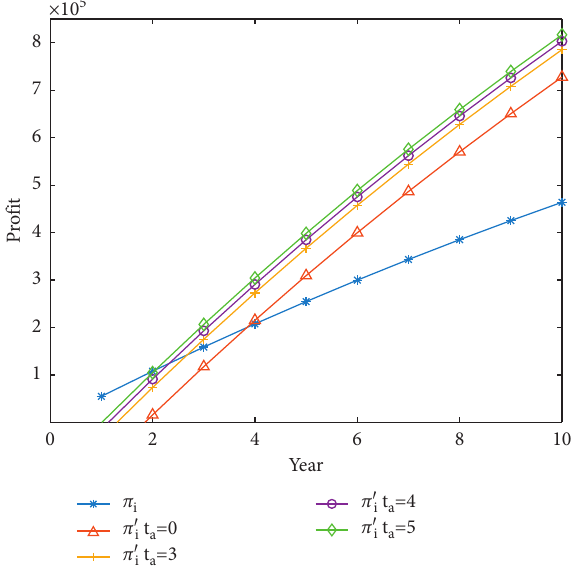
Figure 8: Profits of producers with q t � 0 , 3 , 4 , 5. a